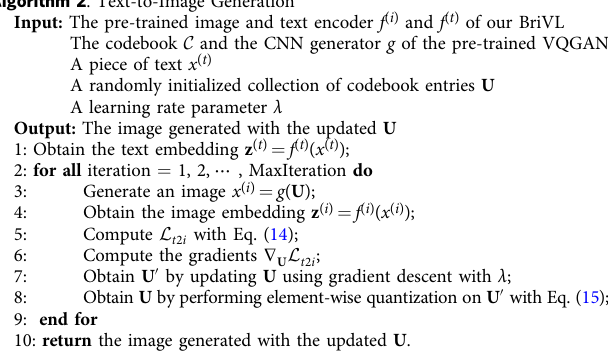
Algorithm 2 . Text-to-Image Generation Input: The pre-trained image and text encoder f ( i ) and f ( t ) of our BriVL The codebook C and the CNN generator g of the pre-trained VQGAN A piece of text x ( t ) A randomly initialized collection of codebook entries U A learning rate parameter